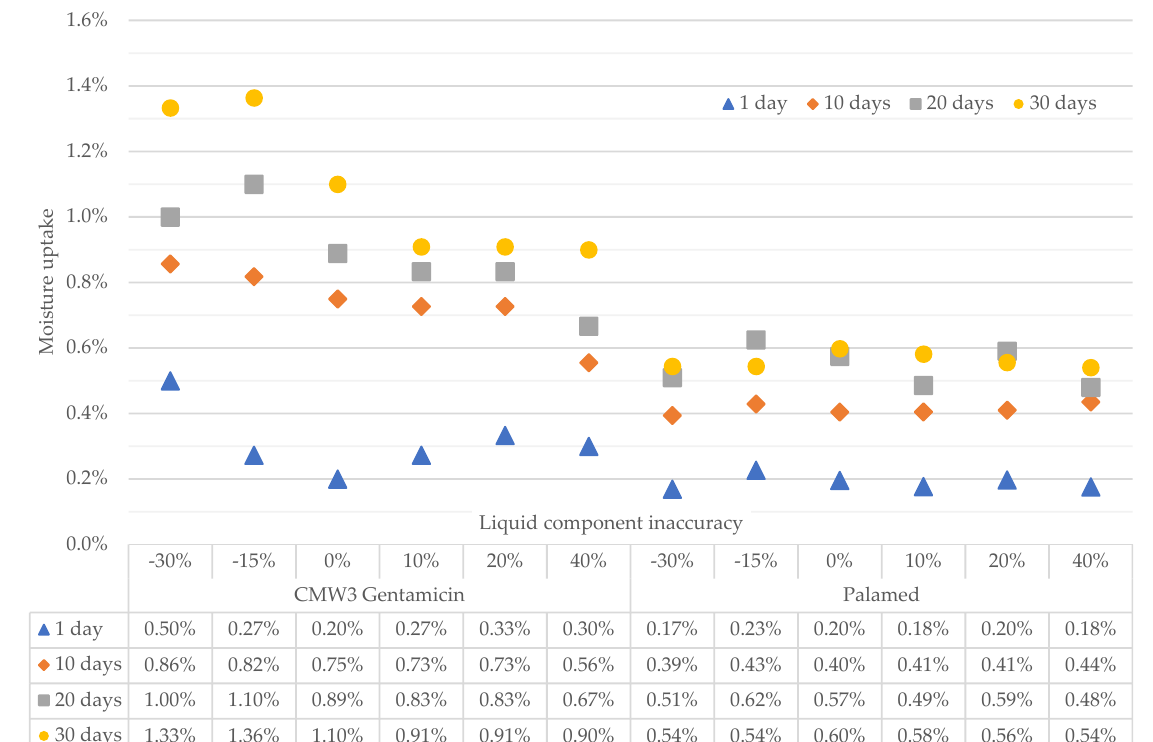
Figure 3. Results of the analysis of the absorption of Ringer’s solution by samples of different compositions during seasoning.